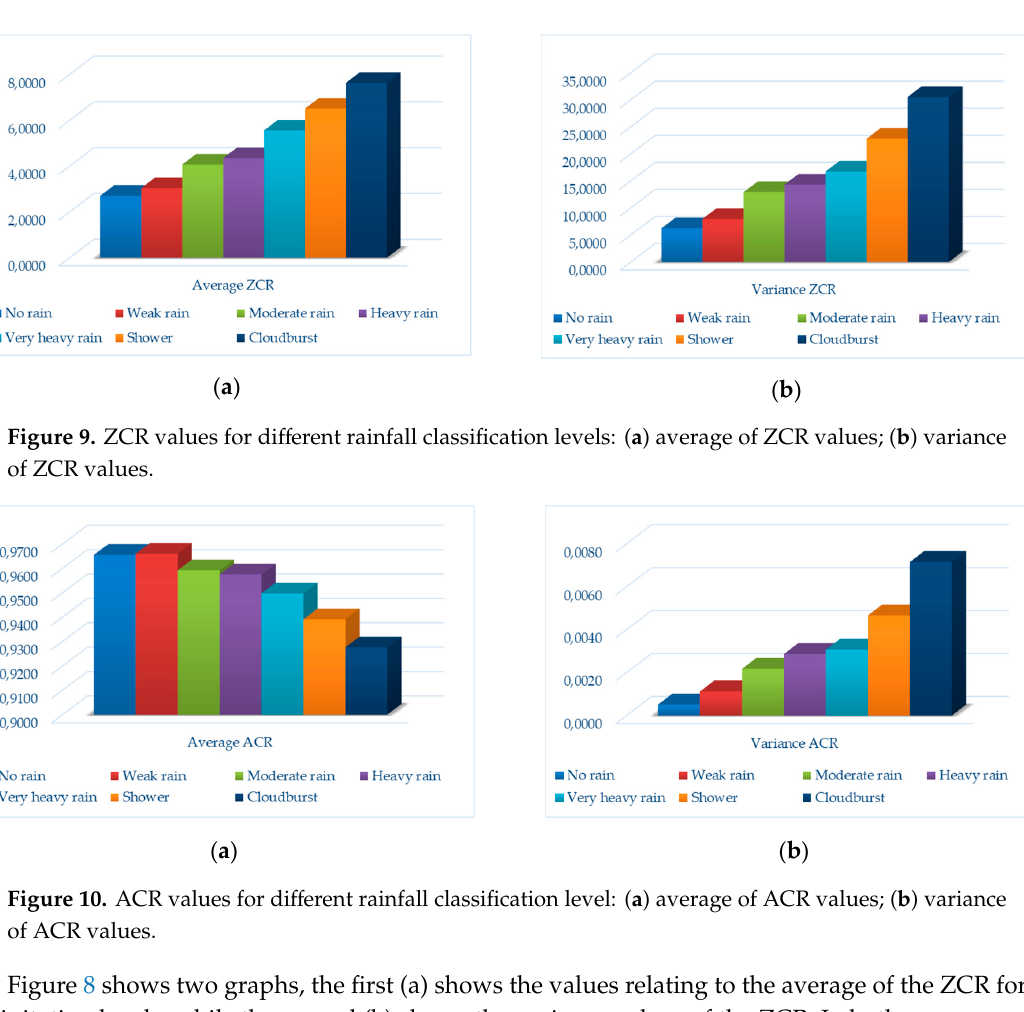
Figure 9. ZCR values for different rainfall classification levels: ( a ) average of ZCR values; ( b ) variance of ZCR values.